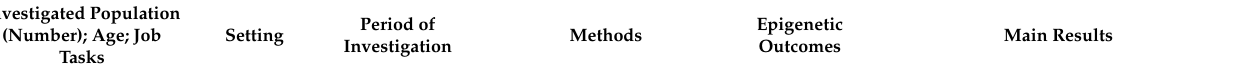
Table 1. Epigenetic changes induced by welding fume